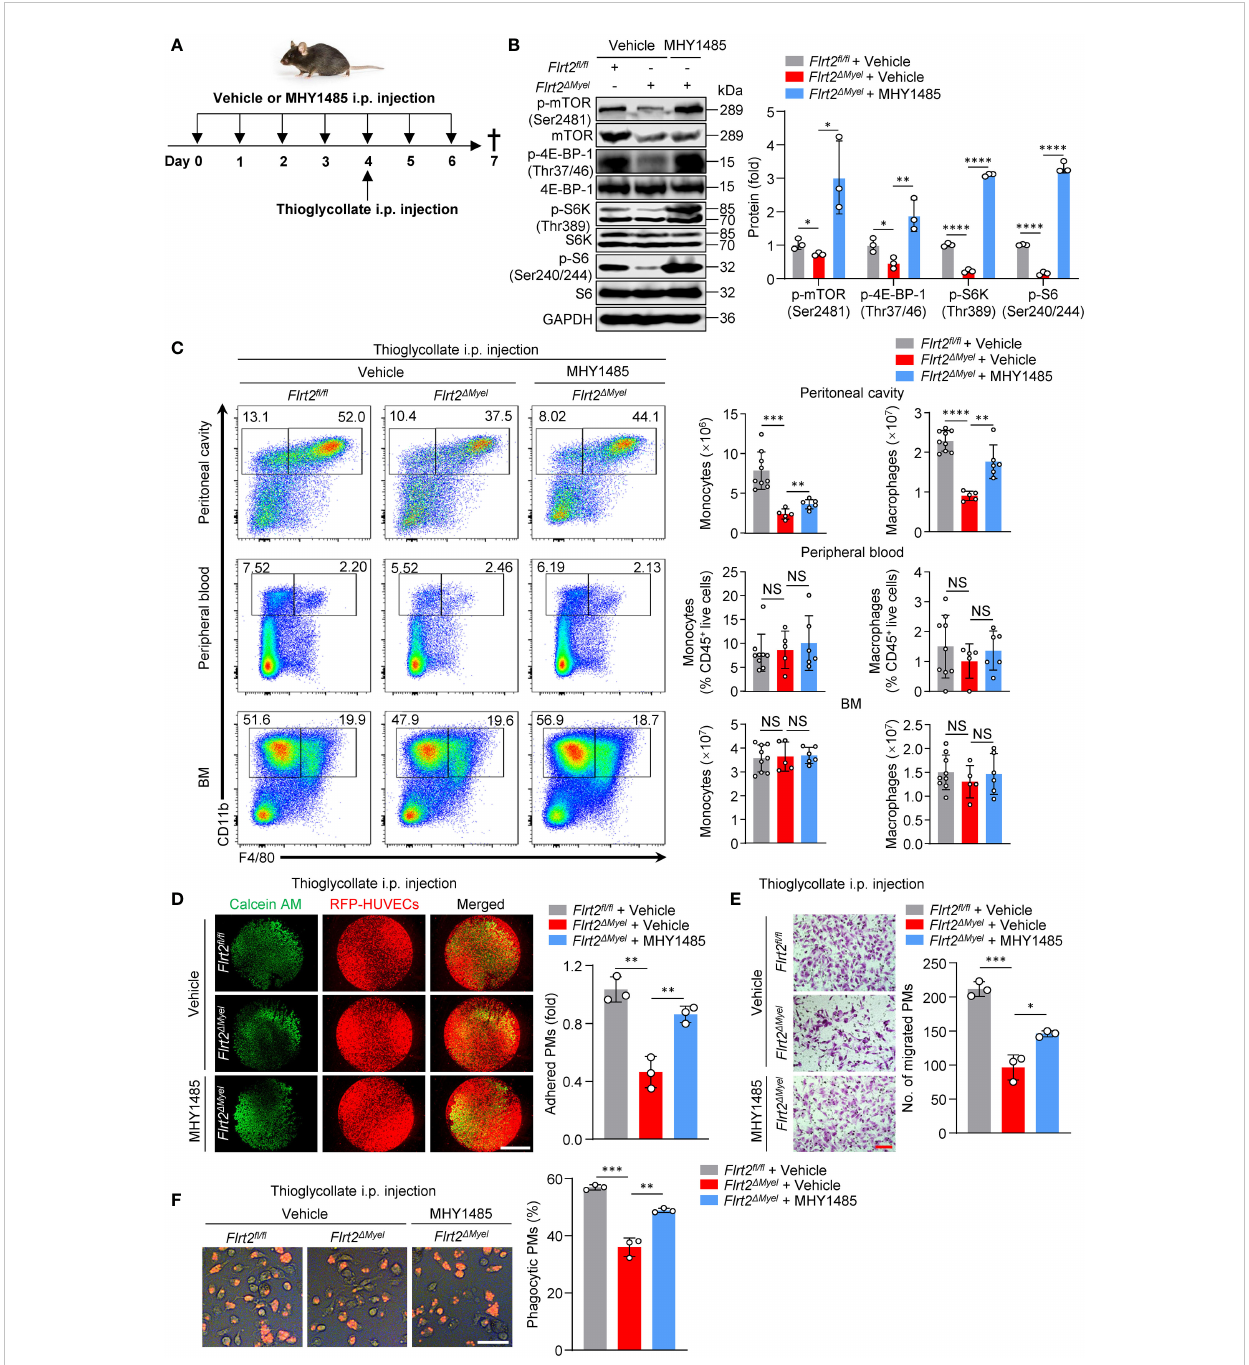
FIGURE 7 MHY1485, an mTOR agonist, abrogates abnormal peritoneal monocyte-macrophage differentiation and macrophage functions of Flrt2 D Myel mice in vivo . (A) Protocol for in vivo rescue experiments. Flrt2 fl / fl and Flrt2 D Myel mice were infused with vehicle or mTOR activator MYH1485 (0.25 mg/kg) for 7 successive days by i.p. injection and were injected i.p. with thioglycollate at day 4. At the end of day 7, samples were collected for fl ow cytometric and functional analyses. (B) Immunoblot analysis of p-mTOR (Ser2481), mTOR, p-4E-BP-1 (Thr37/46), 4E-BP-1, p-S6K (Thr389), S6K, p-S6 (Ser240/ 244), and S6 levels in PMs isolated from Flrt2 fl / fl and Flrt2 D Myel mice (n = 3 mice per group). (C) Representative fl ow cytometric pro fi les and data plots showing the absolute numbers of CD45 + CD11b + F4/80 − monocytes and CD45 + CD11b + F4/80 + macrophages in the peritoneal cavity and BM, and the frequencies of CD45 + CD11b + F4/80 − monocytes and CD45 + CD11b + F4/80 + macrophages in peripheral blood of Flrt2 fl / fl and Flrt2 D Myel mice (n = 5, 6, or 9 mice per group). (D) At the end of day 7, PMs were collected from the above treated Flrt2 fl / fl and Flrt2 D Myel mice and then co-cultured with HUVECs expressing RFP for 6 h, followed by fl uorescent microscopy (n = 3 mice per group). Scale bar, 5 mm. (E) At the end of day 7, PMs were isolated from the above treated Flrt2 fl / fl and Flrt2 D Myel mice and seeded in Boyden chambers for 48 h, followed by crystal violet staining (n = 3 mice per group). Scale bar, 100 m m. (F) At the end of day 7, zymosan was injected i.p. into the above treated Flrt2 fl / fl and Flrt2 D Myel mice for 2 h. PMs